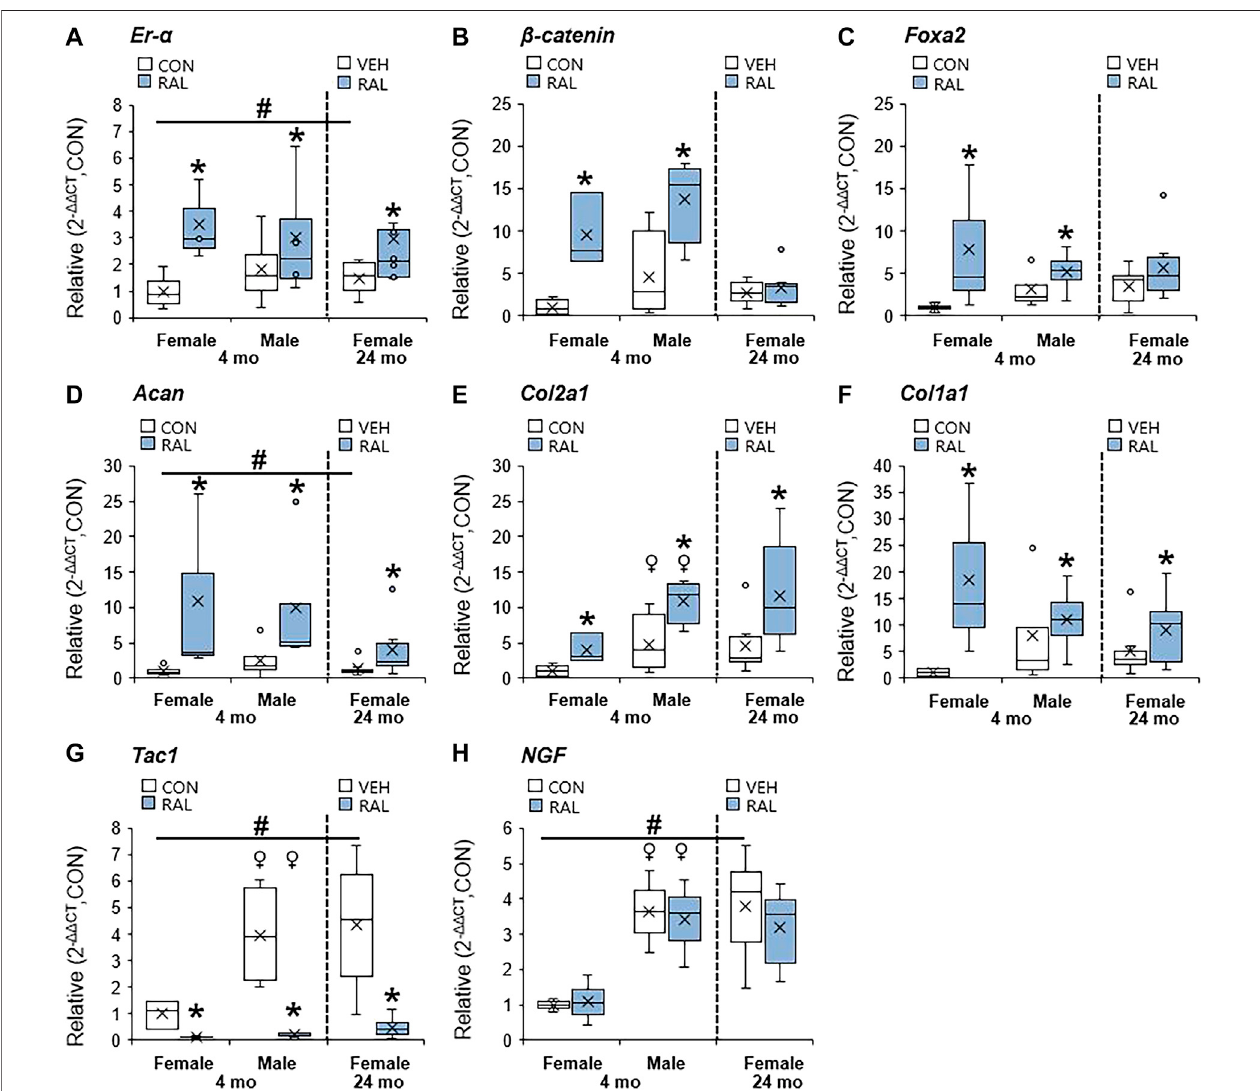
FIGURE 5 | Raloxifene upregulated ER - α , transcription factors, and ECM-related expression, while suppressing the pain-related marker in young-adult and old lumbarIVDs.Geneexpression of (A) ER- α , (B,C) transcription factors ( β -catenin , Foxa2 ), (D – F) ECM( Acan , Col2a1 andCol1a1 ),and (G,H) nerve-related marker( Tac1, NGF )intheIVD.Dataarerepresentedasboxplotswithmeanmarkedascross(x),25/75%deviationlines,andmaximum/minimumwhiskers.*:Control(CON, n =5/sex/ group) vs. raloxifene (RAL), vehicle (VEH, n = 8/group) vs. RAL; # : aging effect (4 months vs. 6 months vs. 24 months); \ : sex effect (male vs. female), p < 0.05.